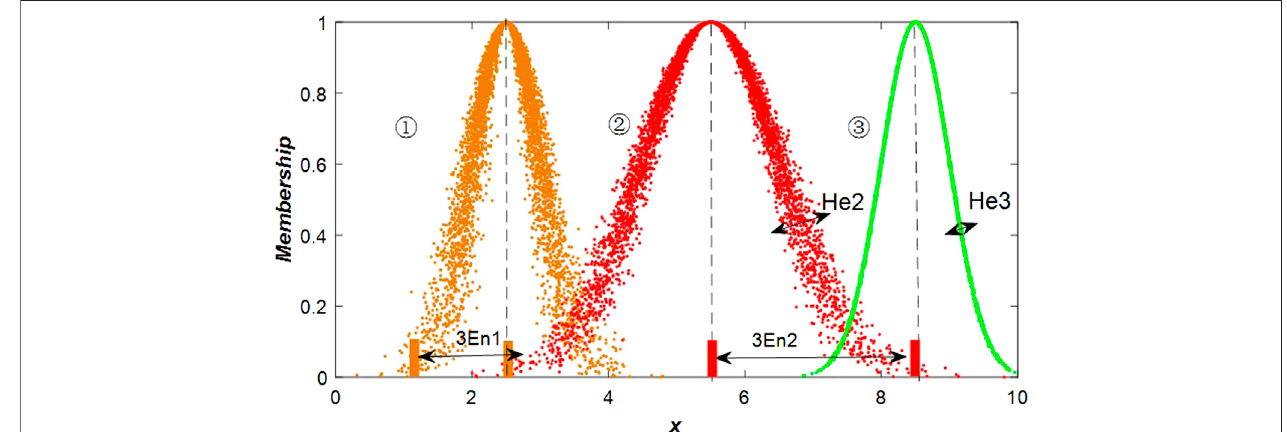
FIGURE 2 | Cloud model feature parameter representation.